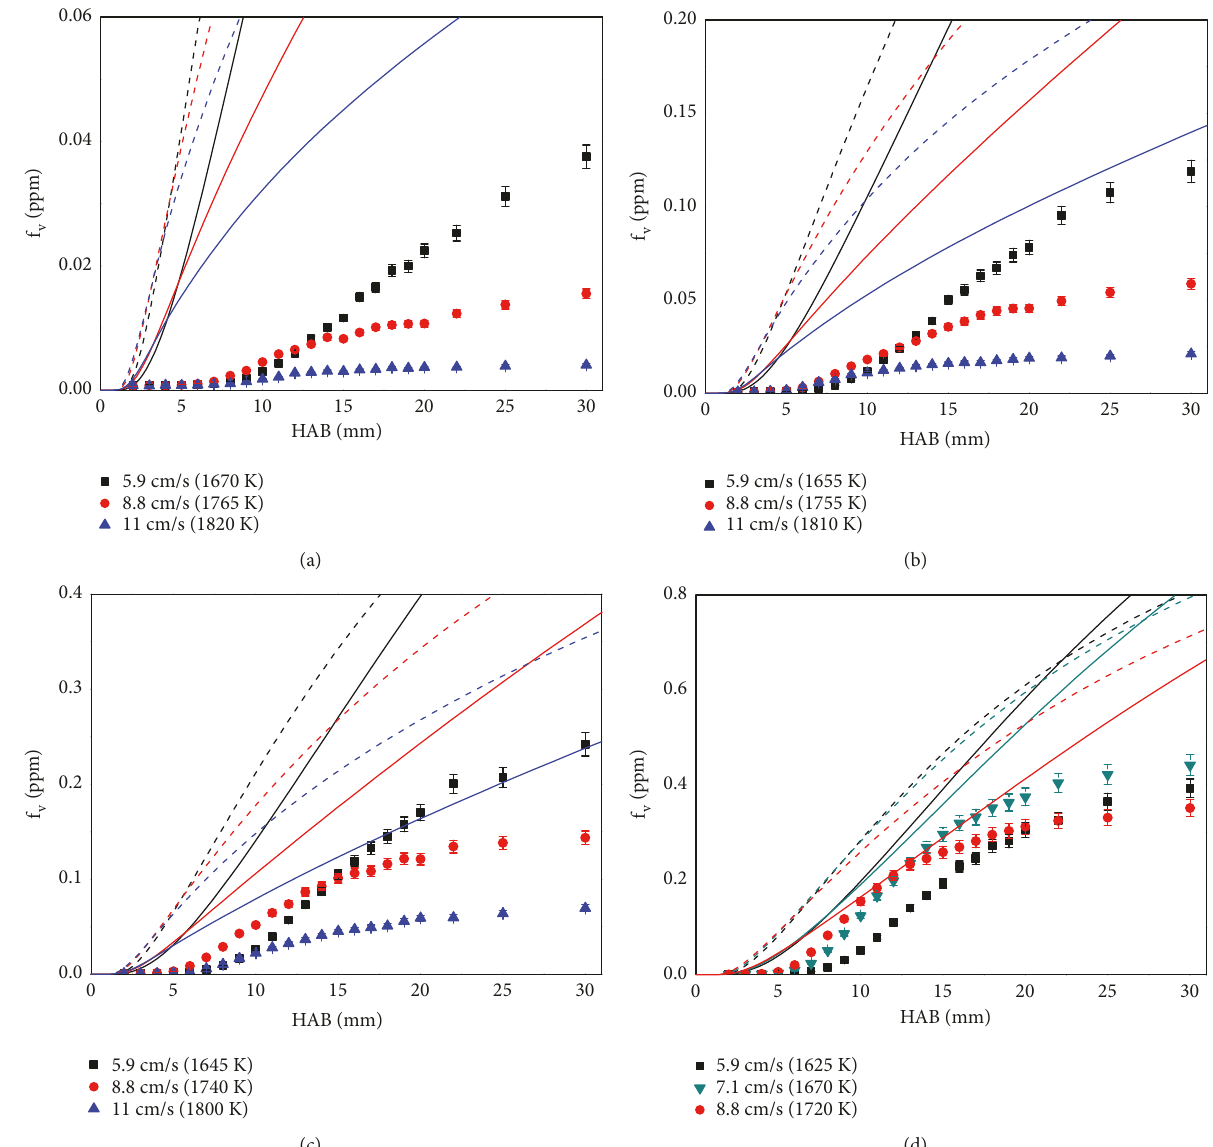
Figure 5: Comparison of 𝑓 V results for three different exit velocities (symbols) and calculations using the models by Leung et al. [19] (dashed lines) and Liu et al. [20] (solid lines) at equivalence ratios (a) 𝜙 = 2.0, (b) 𝜙 = 2.1, (c) 𝜙 = 2.2, and (d) 𝜙 =